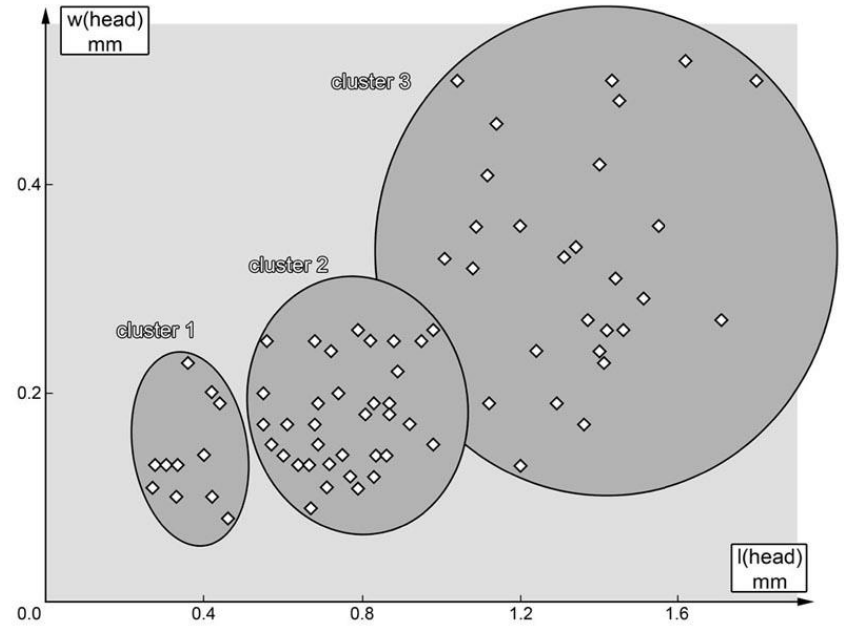
Figure 28. Plotting head width over head length of morphotype 1 larvae. Three more or less distinct clusters can be recognised.